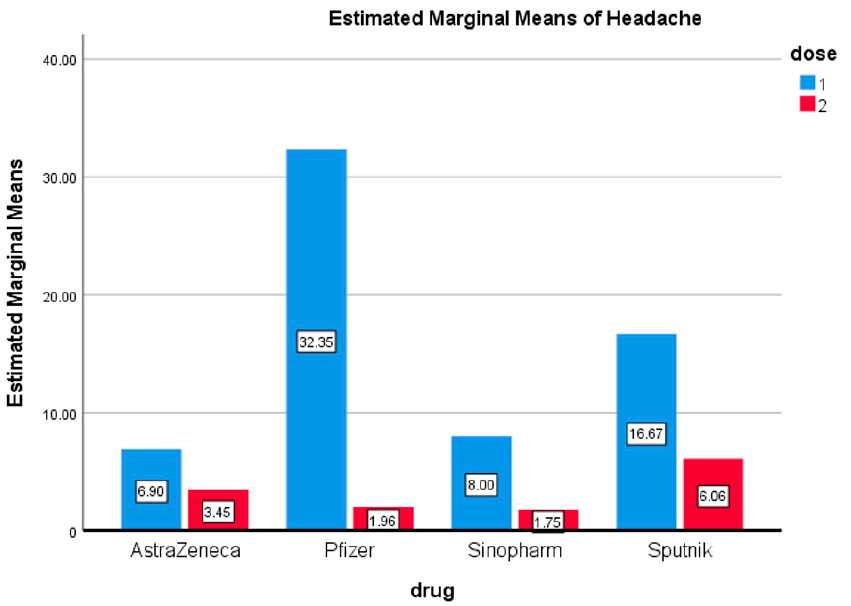
Figure 3. Headache. Estimated marginal means of headache after first and second doses of vaccines used in the Kingdom of Bahrain. used in the Kingdom of Bahrain.